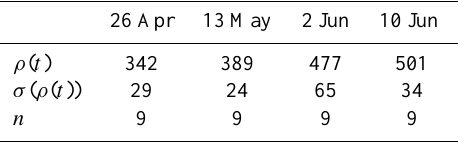
Table 1. Depth-averaged snow density values ρ ( t ) kg step, standard deviation σ ( ρ ( t )) and number of samples ( n)